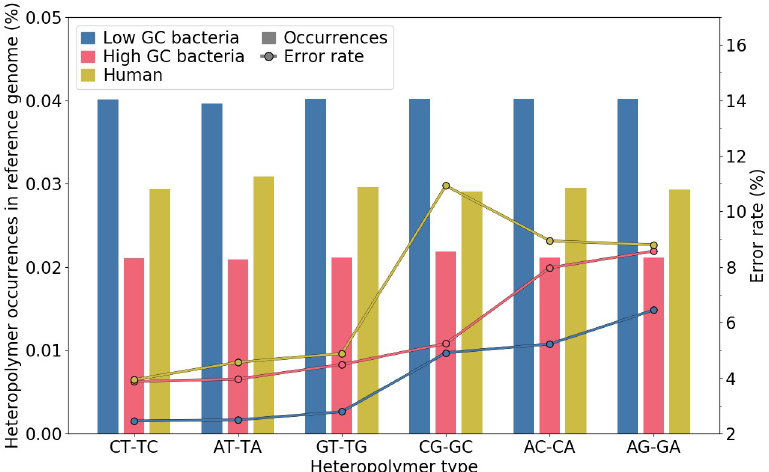
Fig 11. Heteropolymer genomic mean abundance and sequencing error rates. Species were grouped into three categories: low-, high-GC content, and human. Abundance (left axis) is represented with barplots, and error rate (right axis) with